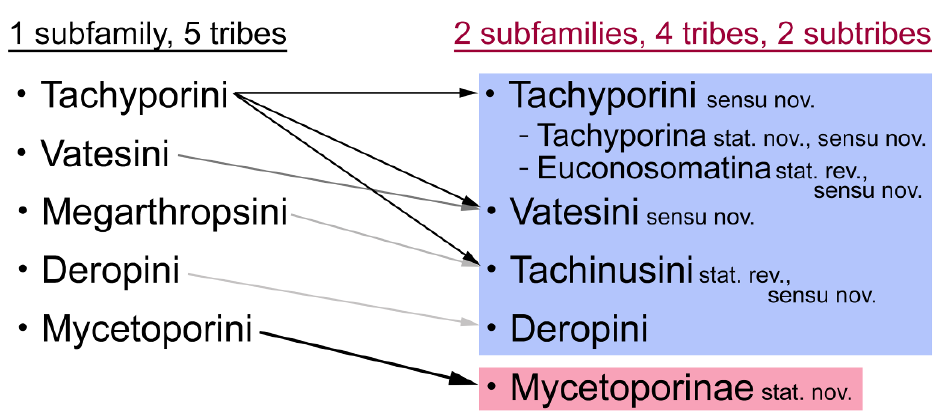
Figure 5. Summary of the previous and current taxonomic frameworks of Tachyporinae and its tribes. Each arrow with different coloration indicates the degree of taxonomic changes (darker arrow with more significant